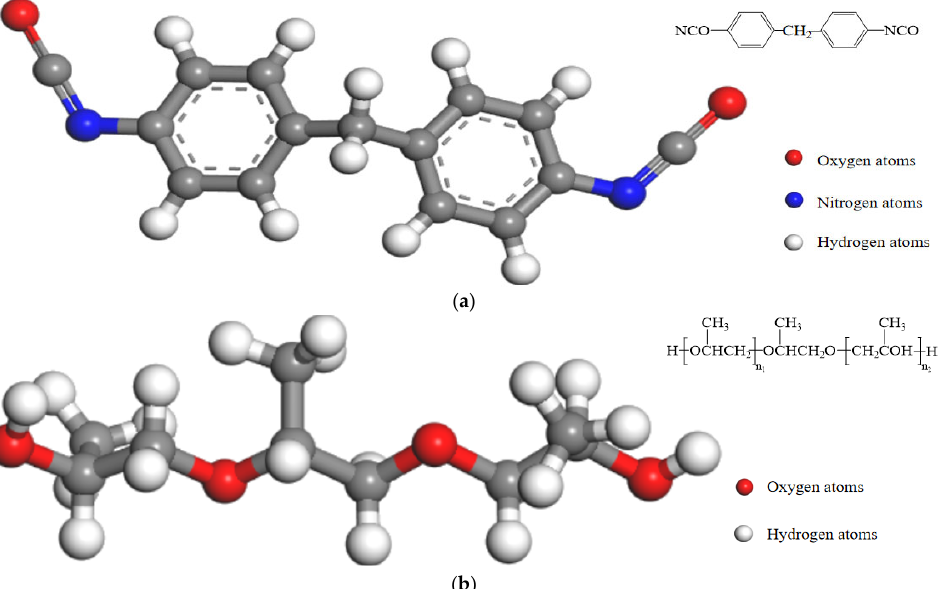
Figure 3. Molecular structures of isocyanates and polyether polyols: ( a ) the molecular structure of MDI; ( b ) the molecular structure of PPG.